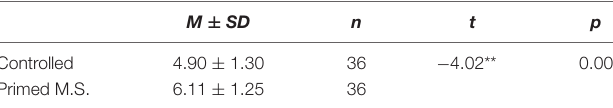
TABLE 1 | T -tests on mental simulation priming on the intention to exercise. M ± SD n t p